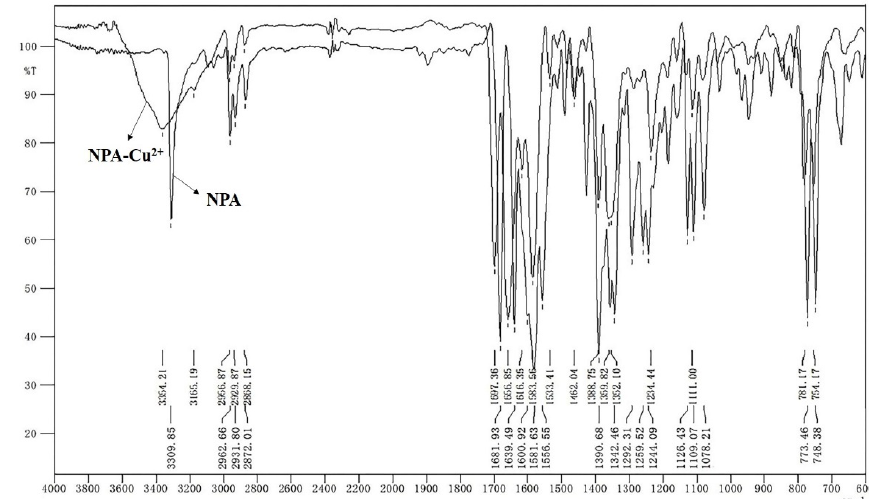
Int. J. Mol. Sci. 2021 , 22 , x FOR PEER REVIEW Figure 4. The FT−IR spectra of NPA compound before and after the introduction of Cu 2+ . Figure 4. The FT-IR spectra of NPA compound before and after the introduction of Cu 2+ .